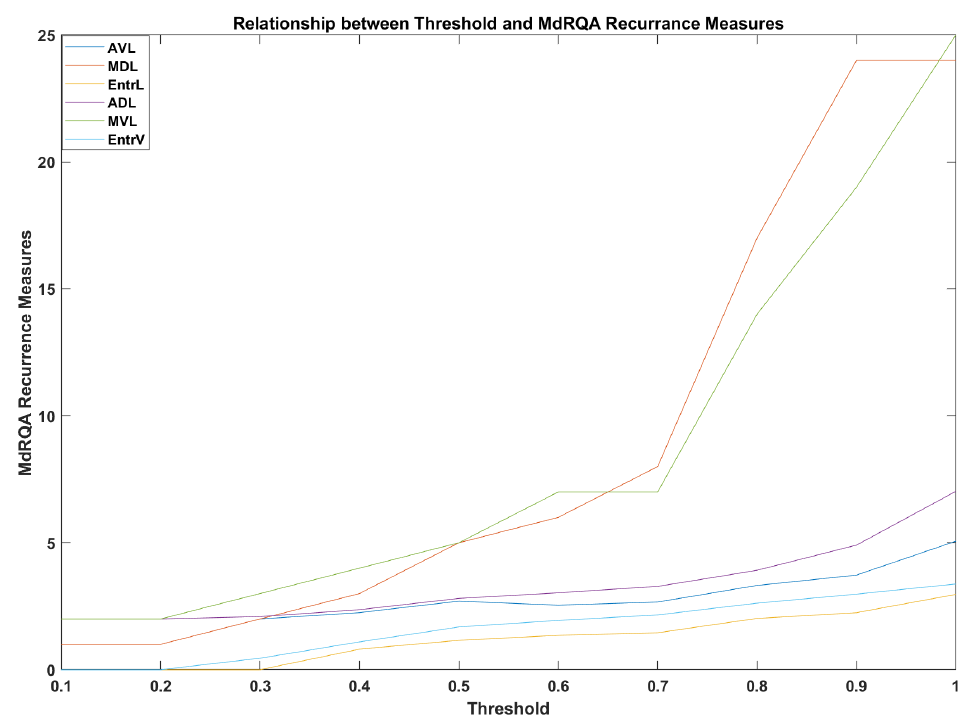
Figure 3. Relationship between threshold and MdRQA recurrence measures for